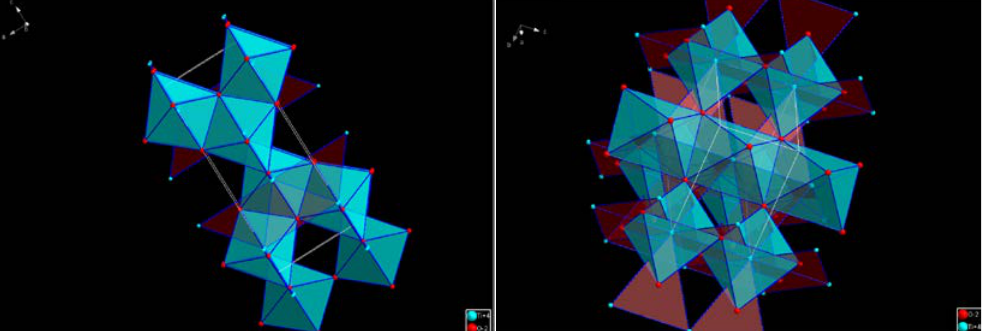
octahedra arrangement in 6